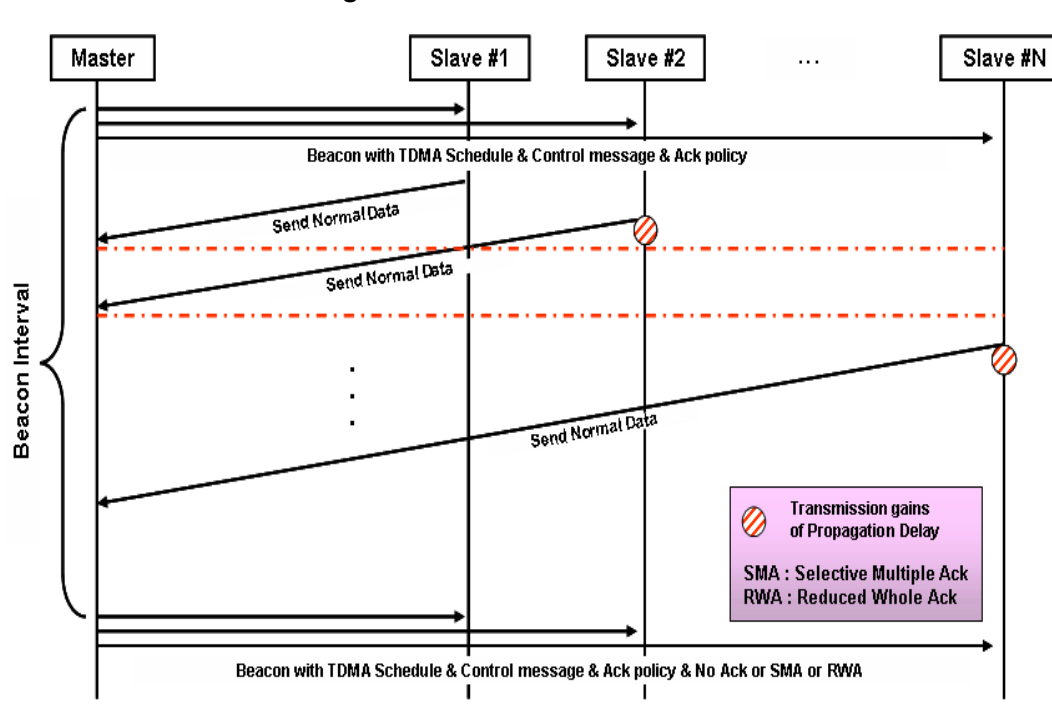
Figure 2. Normal data